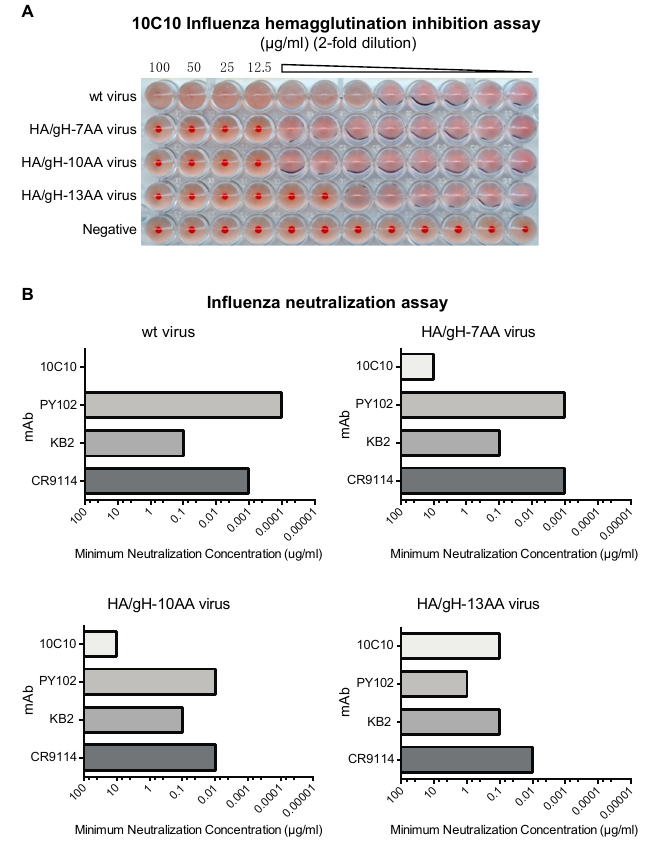
Figure 3. An anti-gH antibody neutralizes the chimeric influenza/CMV viruses. ( A ) Minimal hemagglutination inhibition assays was performed with increasing dilutions (two-fold dilutions starting from 100 µg/mL) of the anti-cytomegalovirus (CMV) gH monoclonal antibody (mAb) (10C10) against wild type influenza virus (wt virus) and chimera HA/gH influenza viruses (HA/gH-7AA, HA/gH-10AA and HA/gH-13AA). The accumulation of chicken red blood cells at the bottom of well indicates the lack of inhibition. ( B ) Wild type influenza virus (wt virus) and chimera HA/gH influenza viruses (HA/gH-7AA, HA/gH-10AA, and HA/gH-13AA) were subjected to influenza neutralization assay (in triplicate) with increasing concentrations (two-fold dilutions starting from 100 µg/mL) of mAb 10C10, PR8 head specific mAb (PY102), and HA stalk specific mAbs (KB2 and CR9114) against wt virus and chimera HA/gH viruses. The virus from infected cells was titered using a classical hemagglutination assay and plotted based on the minimal mAb concentration that neutralizes 100 TCID50 of influenza virus.